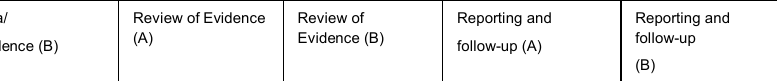
Table 2. Two Sets of Possible Data/Evidence, Review, and Follow-up Data/